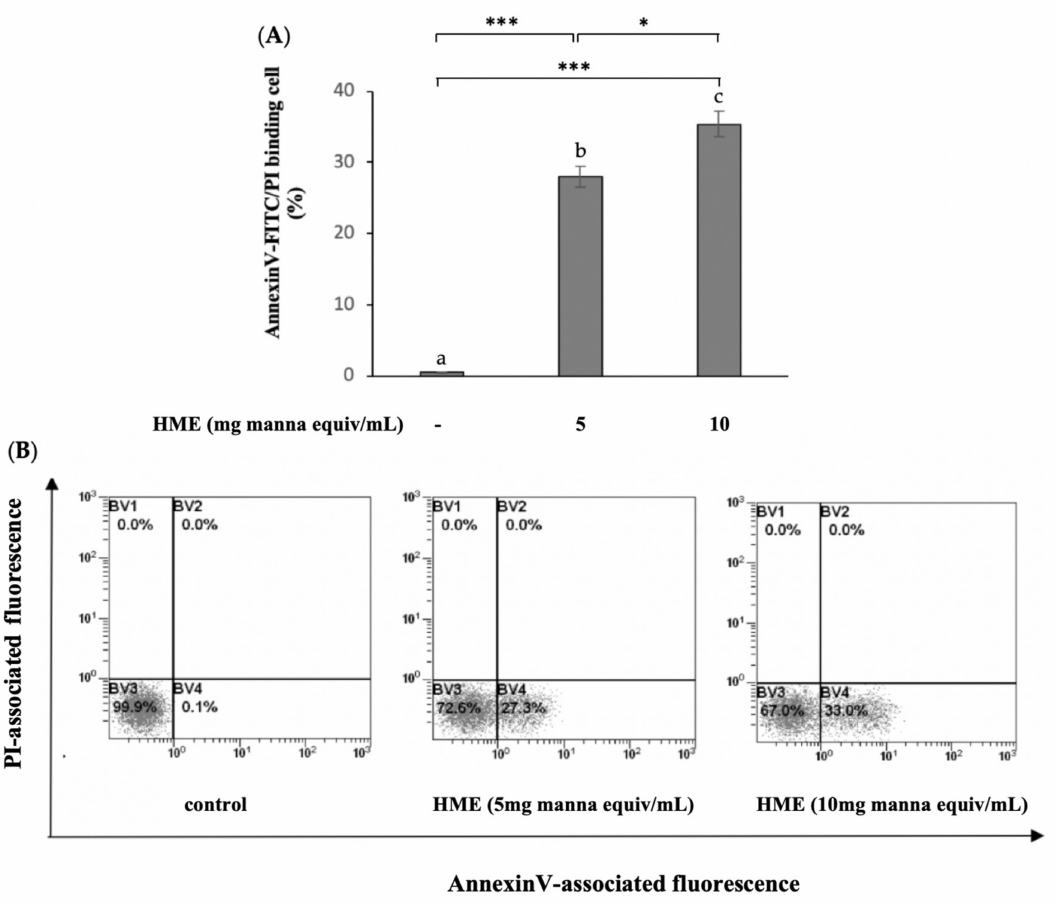
Figure2. ApoptosisinducedbyHMEonHCT-116cells.